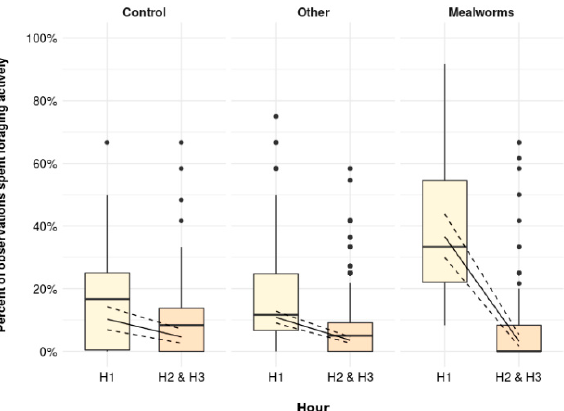
Figure 3. The percentage of observations spent foraging actively immediately after scattering was provided (H1) and later in the day (H2 and H3) for Control (no scattering), Other (scattering of shavings, whole wheat, alfalfa, or cabbage), and Mealworms ( p = 0.001). Boxplots show medians, lower, and upper interquartile range of raw data. Whiskers indicate 1.5 times the interquartile range. Solid lines represent estimated means and dashed lines represent 95% confidence intervals.